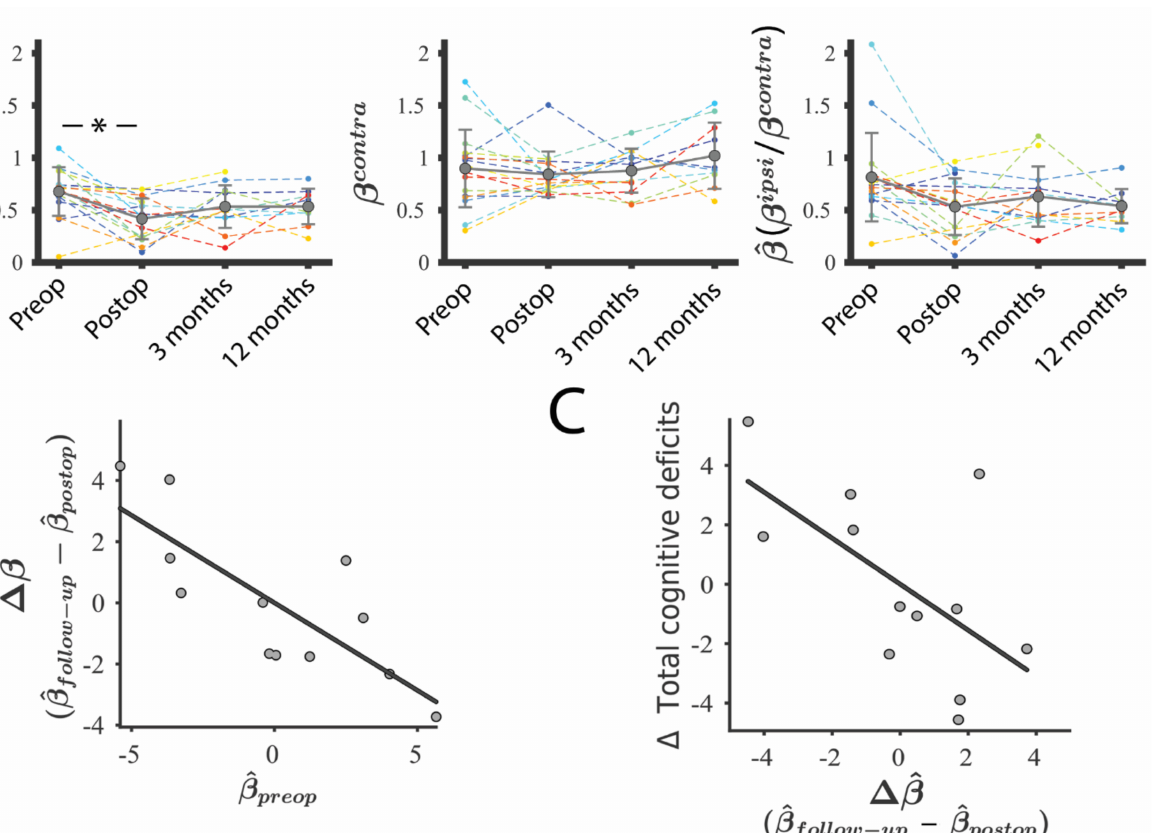
FDR corrected; Figure 5A). To account for the differential location of the lesioned tissue, β values were normalised before comparing patients. The normalised lesion–GS coupling, ˆ β , was defined as the ratio between ipsilateral (Figure 5A, left) and contralateral (Figure 5A, middle) values of β . ˆ β was reduced after surgery (Figure 5A, right), but significance did not survive correction for multiple comparisons across assessments (P uncorrected = 0.02; P FDR-corrected = 0.05). The rate of change of normalised coupling during the recovery period, ∆ ˆ β , was significantly associated with ˆ β preop ; that is, patients with higher tumour–GS coupling before surgery tended to show a decrease in lesion–GS coupling during recovery (R 2 = 0.63; p = 0.002; Figure 5B). We also observed a significant negative association between ∆ ˆ β and the total number of cognitive deficits acquired during recovery (Figure 5C). Thus, individuals showing the greatest decrease in lesion–GS coupling during recovery (negative ∆ ˆ β ) were more likely to have a larger number of newly acquired cognitive deficits following